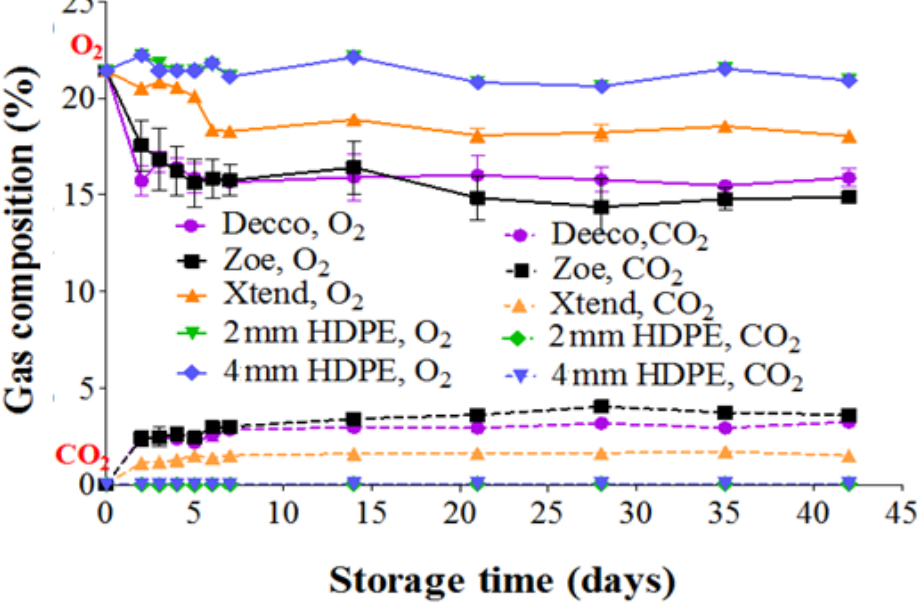
Figure 1. Gas composition inside plastic liners packed with pomegranate fruit (cv. Wonderful) stored at 5 °C and 90% relative humidity (RH). HDPE: high density polyethylene.